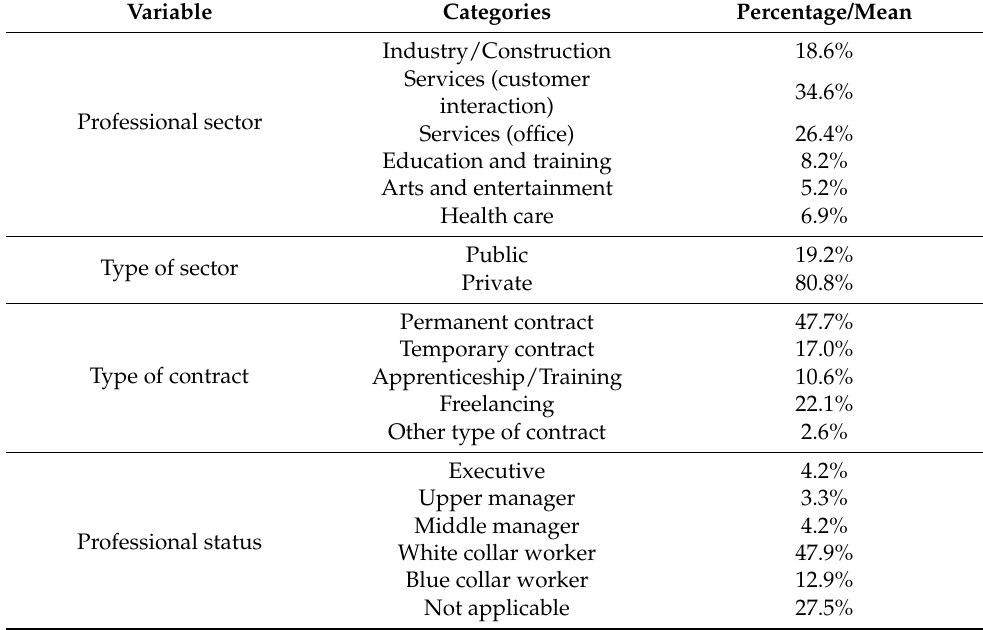
Table 1. Demographic and professional characteristics of the